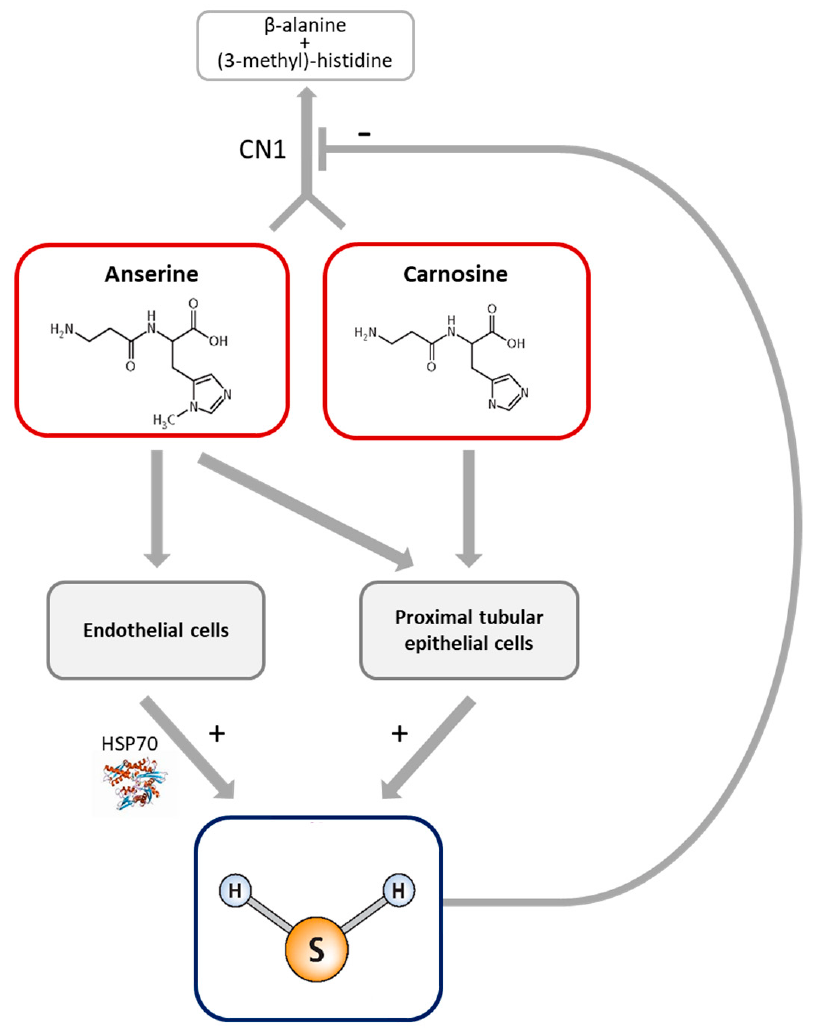
Figure 6. Anserine and carnosine induce H 2 S formation in a cell type- and Hsp70-specific manner within a positive feedback loop with CN1.